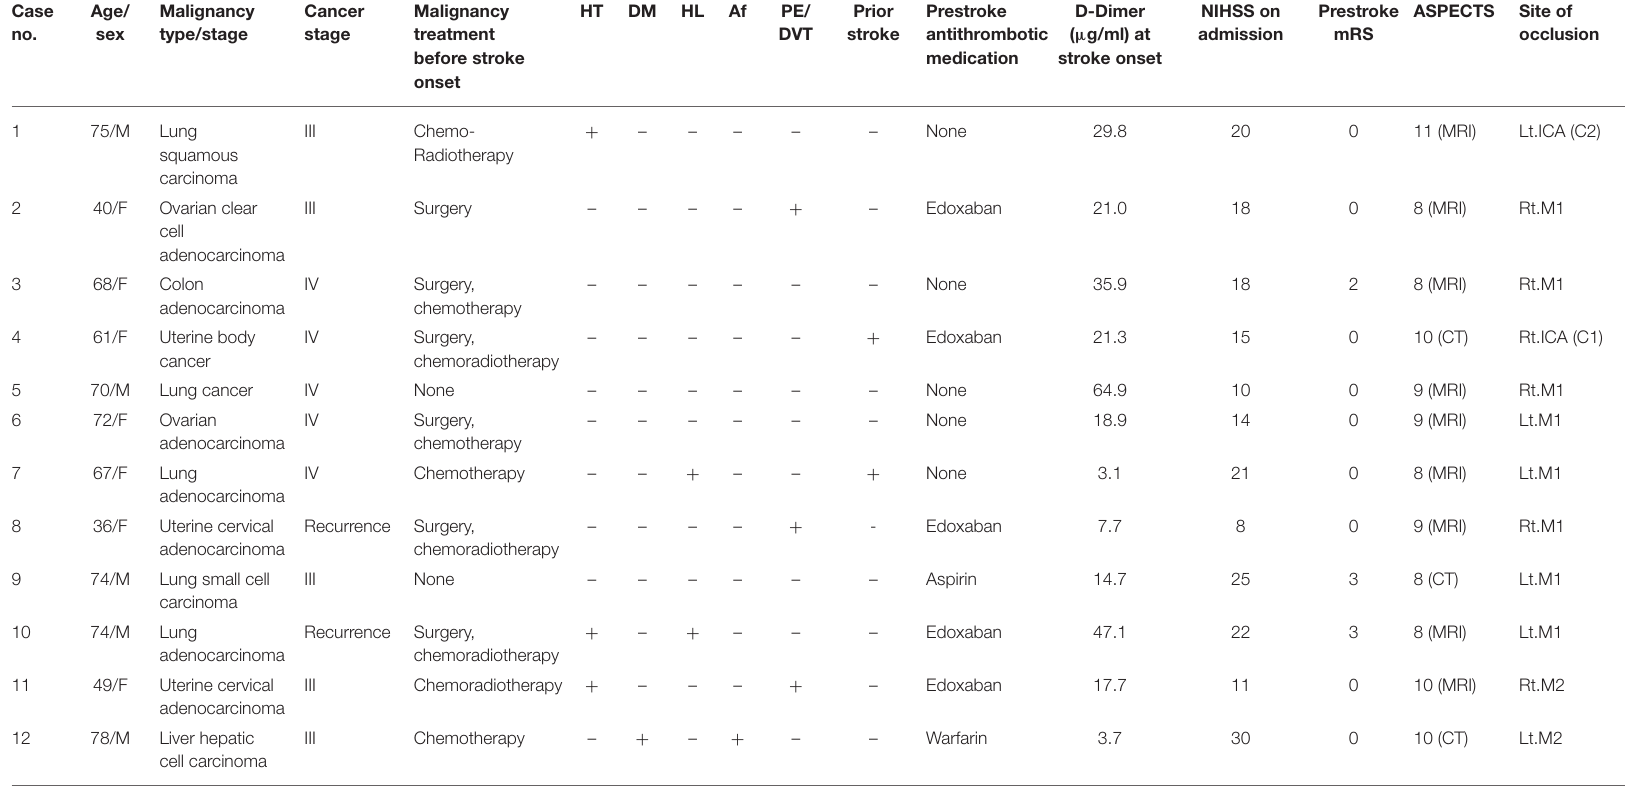
TABLE 1 | Patient characteristics. Case